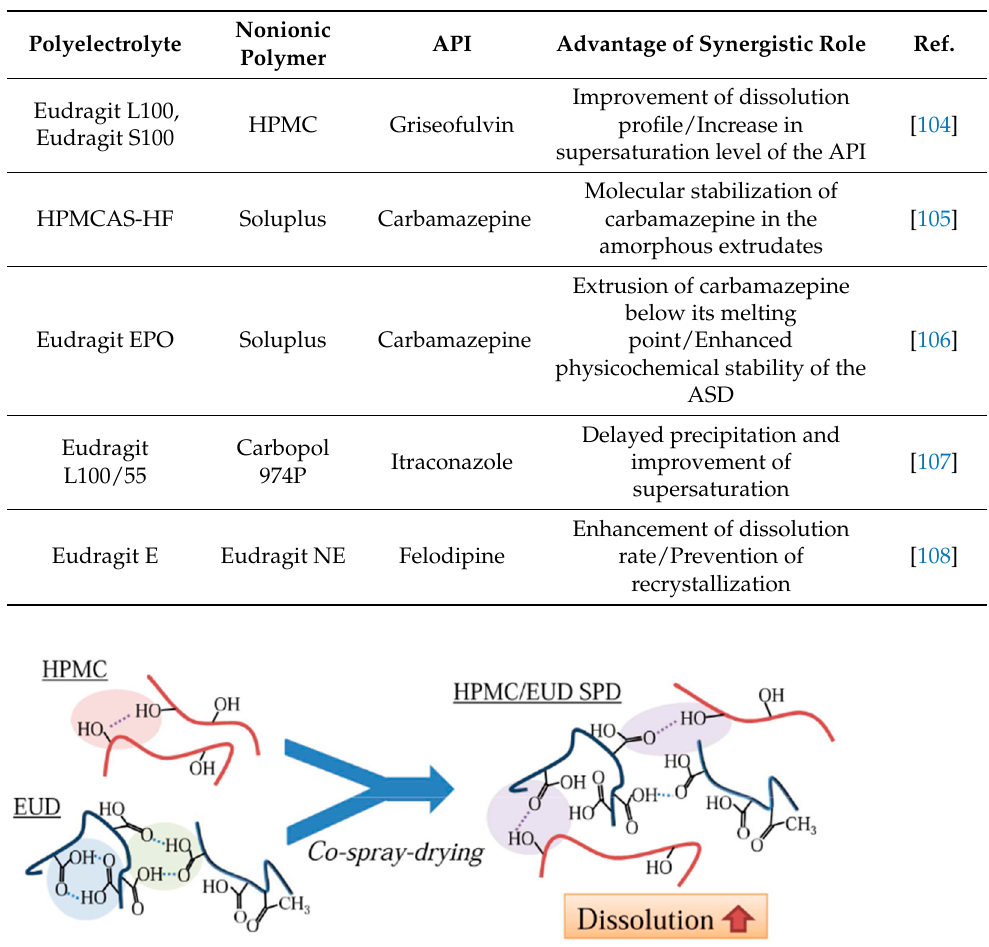
Figure 4. Synergistic role of Eudragit and HPMC in dissolution enhancement. (Adapted with permission from [104], Elsevier, Inc., 2017.)